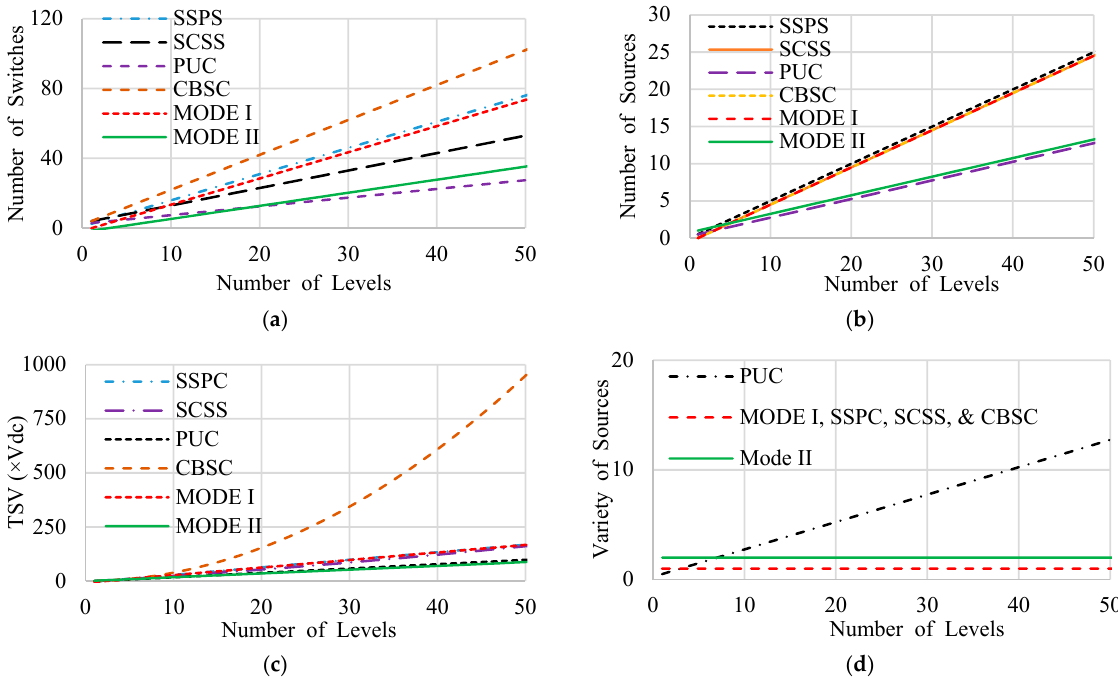
Figure 6. Comparing the proposed MLI with others in literature ( a ) number of switches; ( b ) number of dc sources; ( c ) total standing voltage (TSV) and ( d ) variety of dc voltage sources with respect to number of levels.